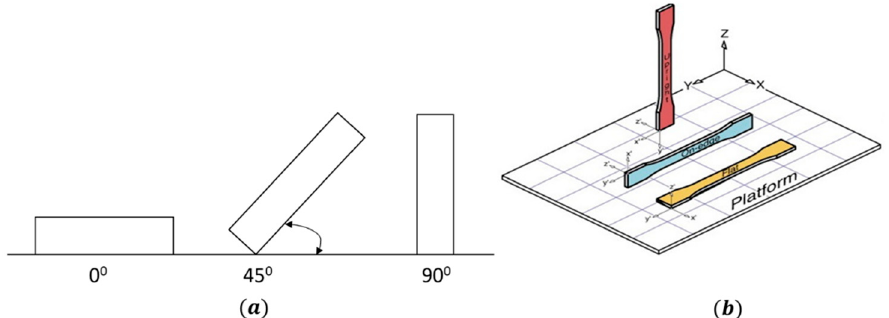
Figure 1. Build orientation: ( a ) numerical; ( b ) categorical [11]. 87